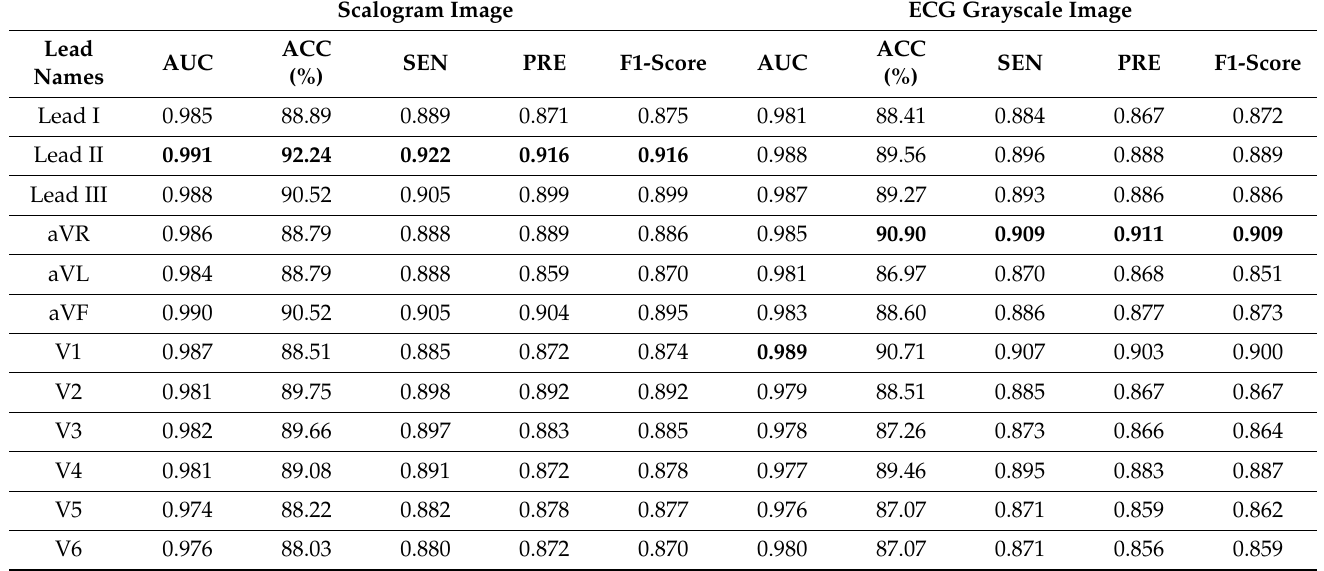
Table 3. Diagnostic performance of individual base learners for scalogram and ECG grayscale images. Scalogram